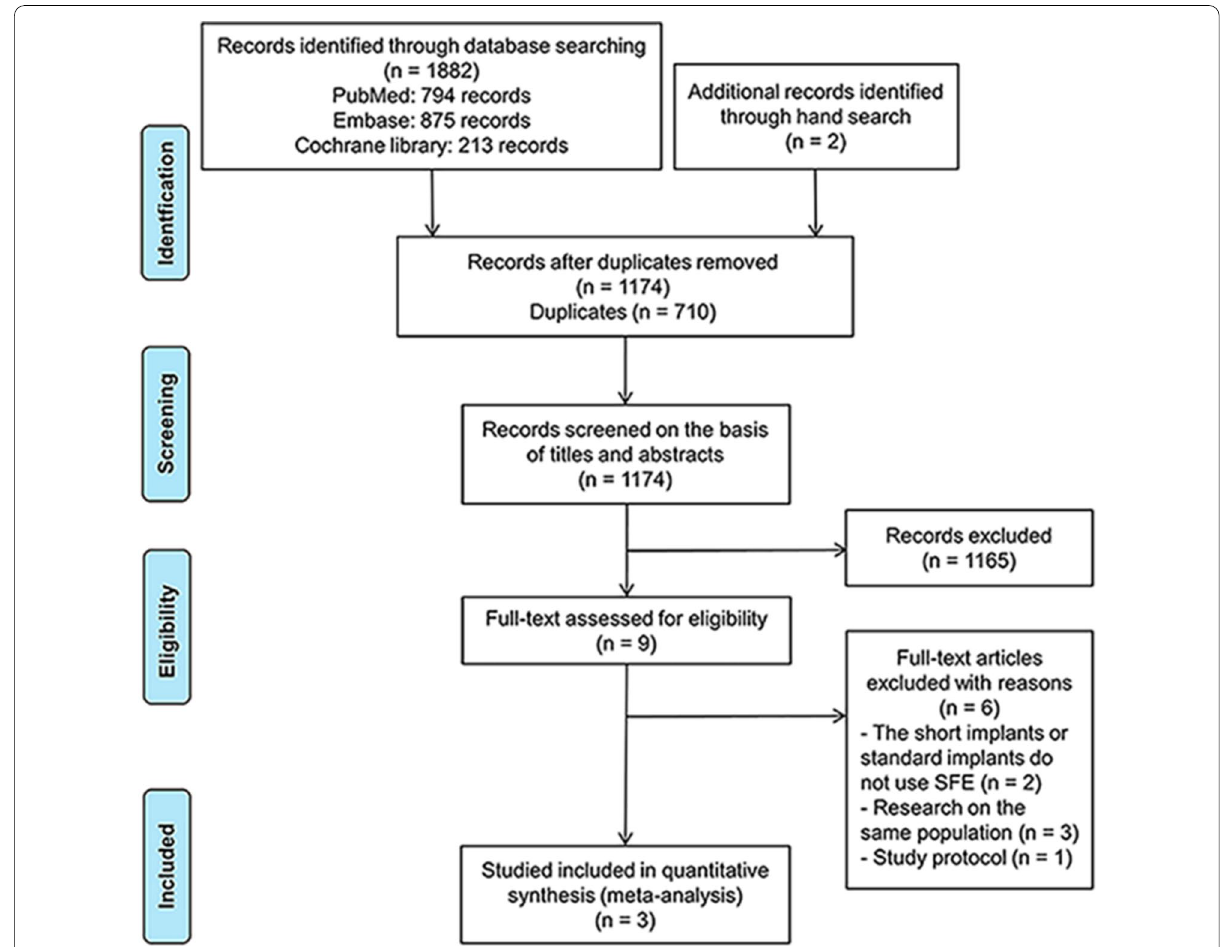
Fig. 1 Flow diagram of the search